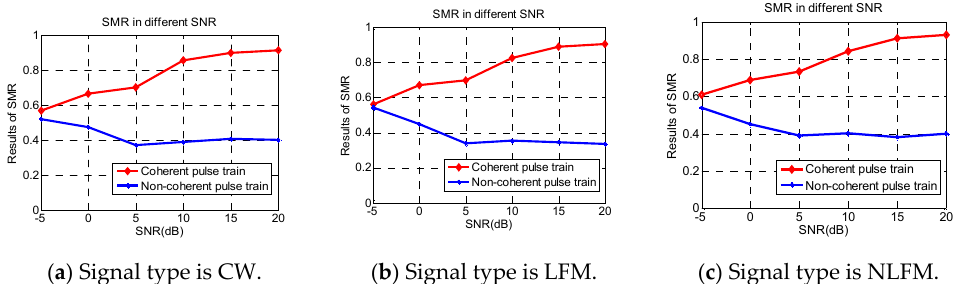
Figure 5. SMRs (the ratios of the secondary peak value to the main peak value) of different signal types in different signal-to-noise ratios (SNRs).